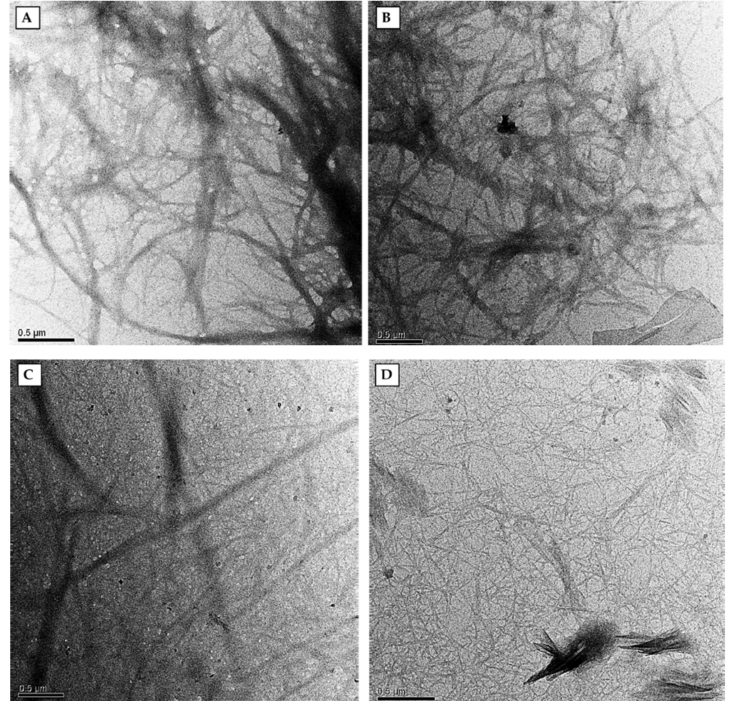
Figure 2. TEM images of virgin ( A ) and waste ( B ) enzymatic-treated cellulose nanofibers and of virgin ( C ) and waste ( D ) TEMPO-oxidised cellulose